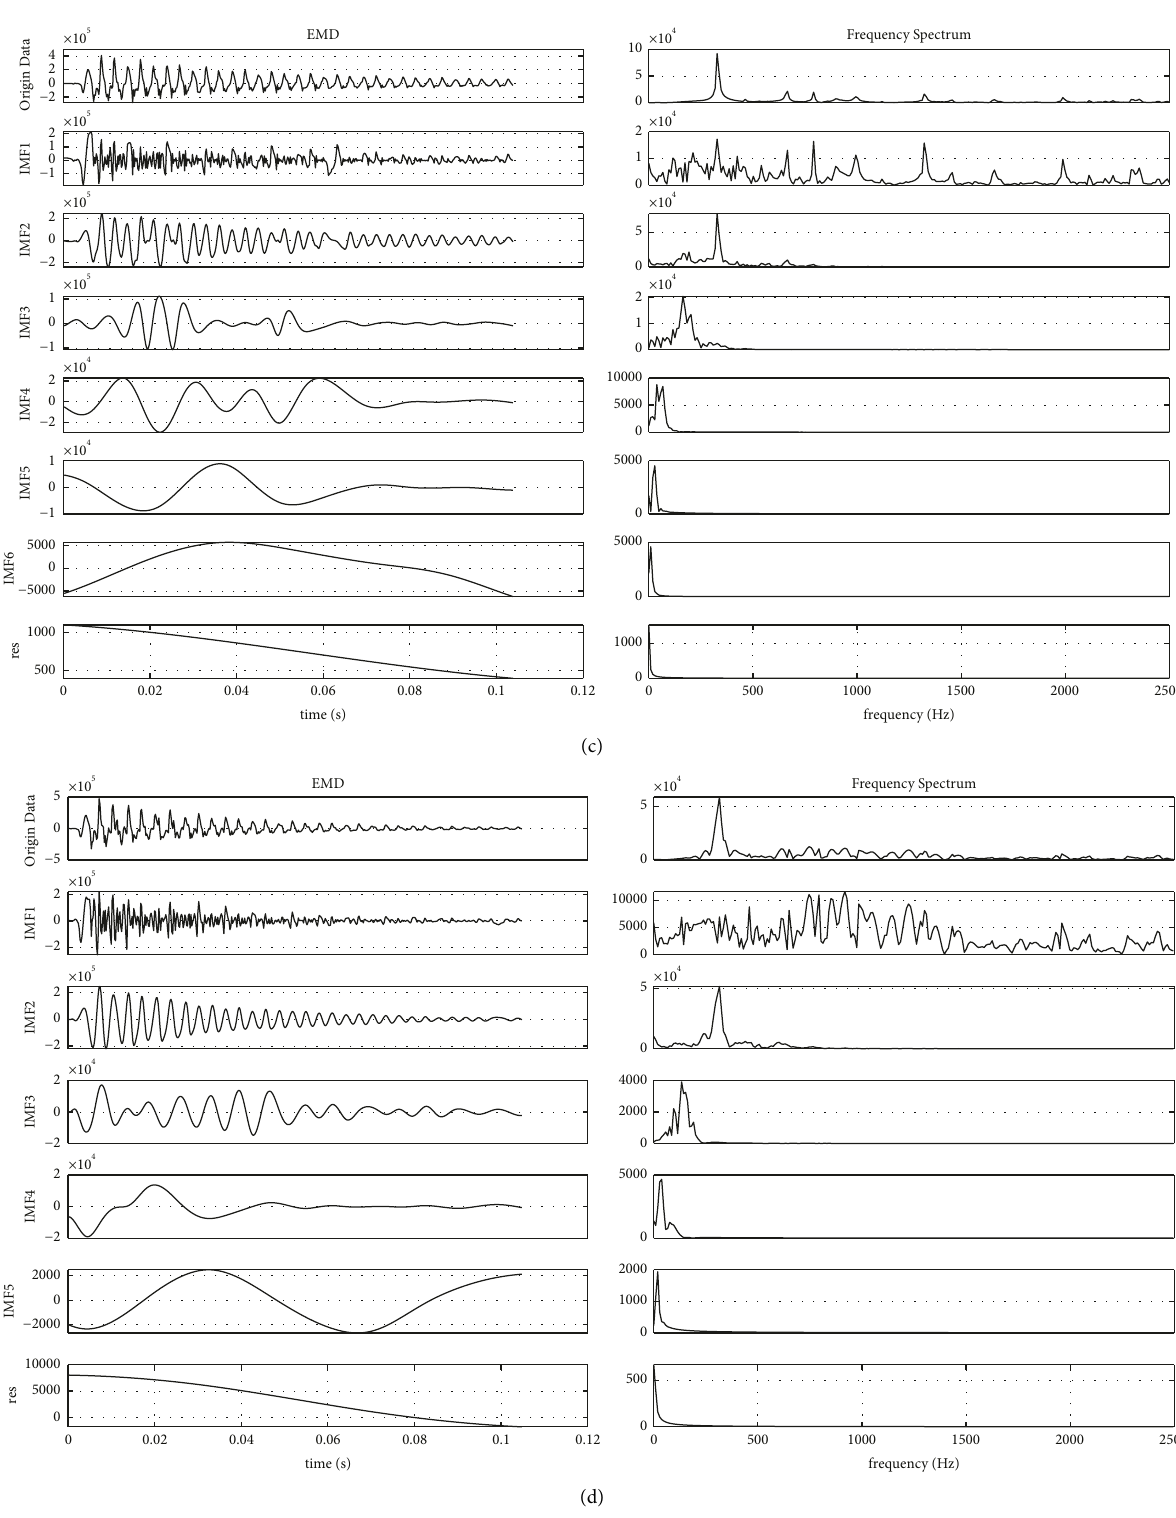
Figure 25: Acceleration signal EMD decomposition and frequency response curves of 6 bolts’ flange structure under 1500N impact load. (a) Tightening preload of 5000N. (b) Tightening preload of 5000N with one bolt loosened to 3000N. (c) Tightening preload of 5000N with one bolt loosened to 300N. (d) Tightening preload of 5000 N with two adjacent bolts loosened to